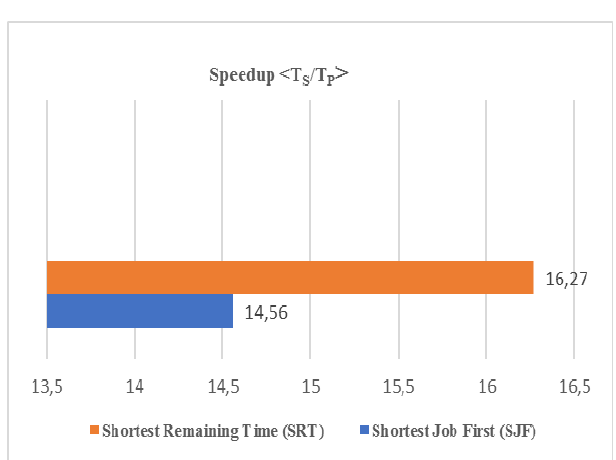
Figure 3. represents the Speedup of two algorithms SRT and SJF Figure 3: shows that the acceleration of SRT algorithms is higher than that of the SJF algorithm, implying that